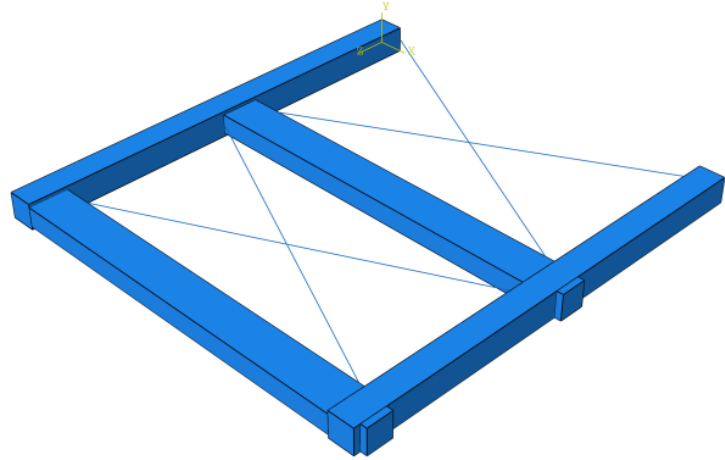
Figure 8. The finite element model. Table 2. Lateral shift values of the structure Table 1. Ontogenetic parameters of SMA.